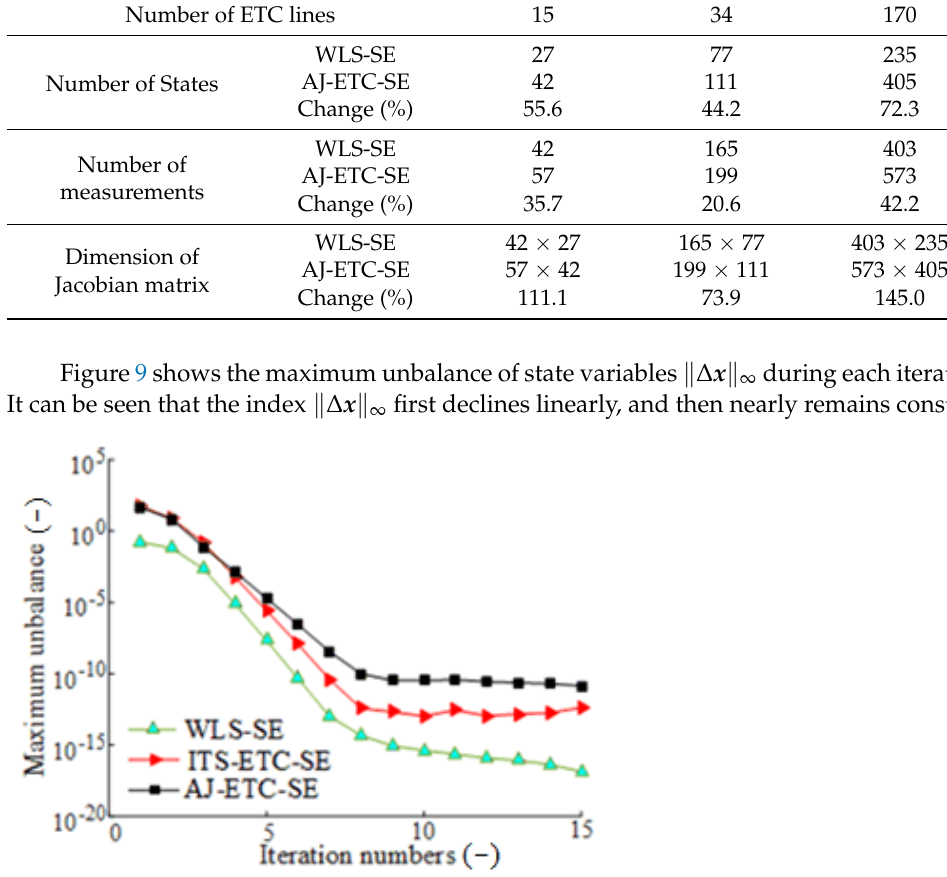
Table 5. Comparison of computational complexity of the AJ-ETC-SE approach and WLS-SE method.